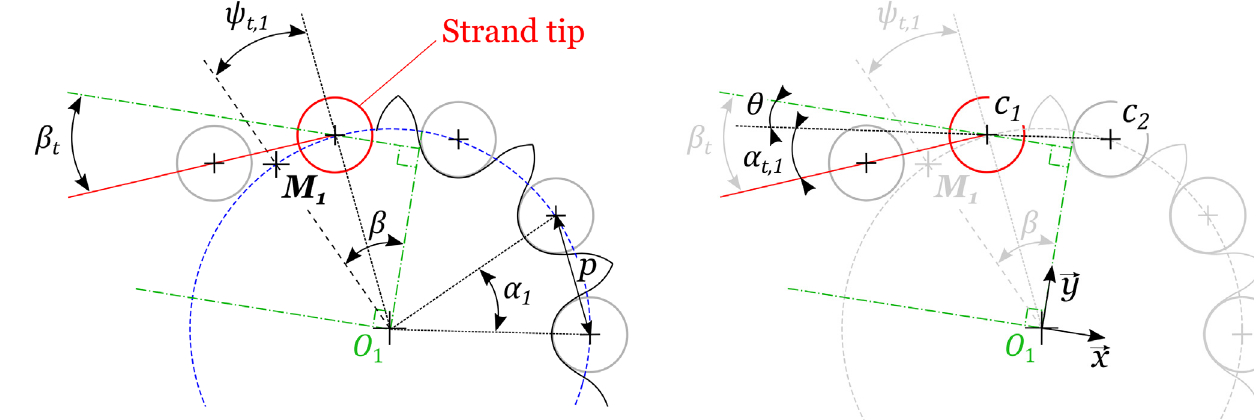
Fig. 4. De fi nition of c t ,1 and b t .